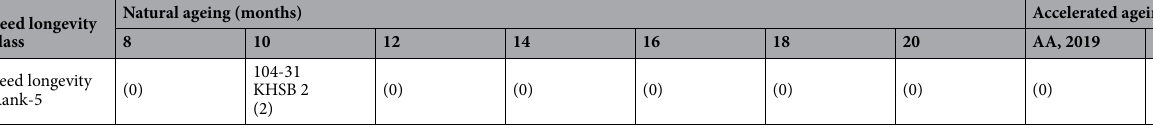
Table 4. Ranking of genotypes in to different seed longevity classes in soybean based on natural and accelerated ageing. Values in parenthesis indicate the number of genotypes in each rank.